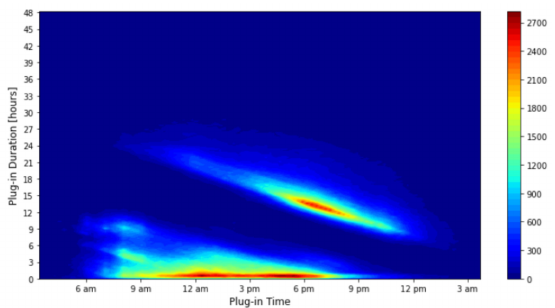
Figure 7. Density distribution of the final